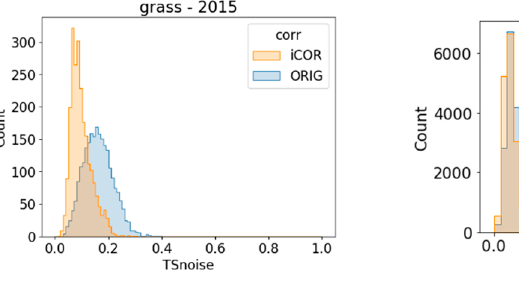
Figure 12. Histograms of time series noise calculated for the classes Grass (NDVI), Trees (LAI) and Urban (NDVI) for the original and ICOR data (colors) for the SONIA site.